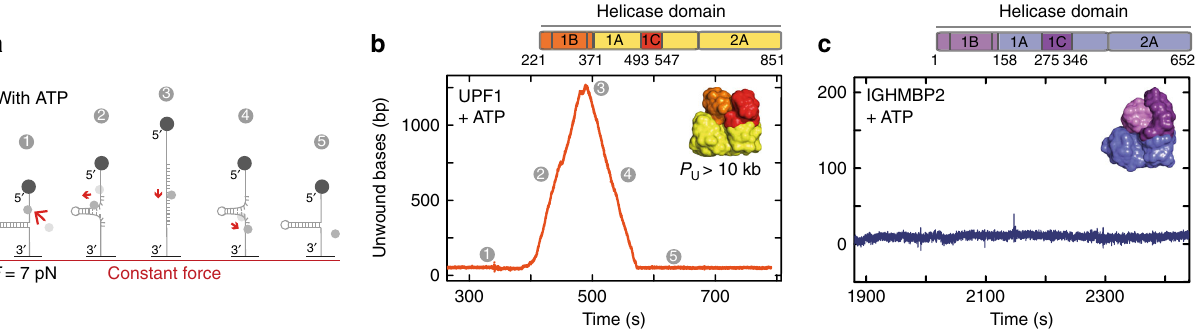
Fig. 1 Closely related SF1-B helicases present very different processivities. a Schematic representation of the single-molecule experimental setup. A 1.2 kb DNA hairpin substrate tethers a magnetic bead to a glass surface and is subjected to the tension exerted by magnets pulling on the bead. Different phases of beads movements in the presence of ATP and an active 5 ′ to 3 ′ unwinding helicase are shown not to scale. b Helicase domain organization of yUPF1 made of the RecA domains 1A and 2A (yellow) and the domains 1B (orange) and 1C (red) protruding from the domain 1A (Protein Data Bank (PDB) identi fi er 2XZP). Experimental trace showing unwound bases with 2 mM ATP and yUPF1 at a constant tension on the hairpin of 7 pN. c Same as b with IGHMBP2 except that domains 1A and 2A are in blue, 1B in light purple, and 1C in purple